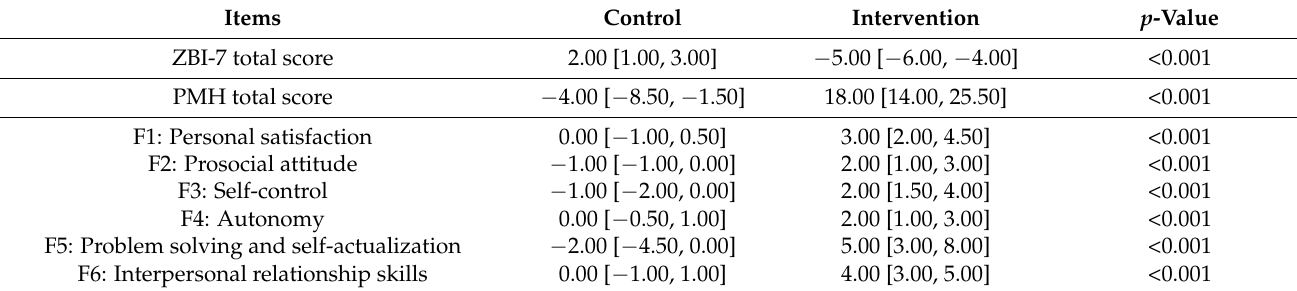
Table 4. Changes between baseline and post-intervention